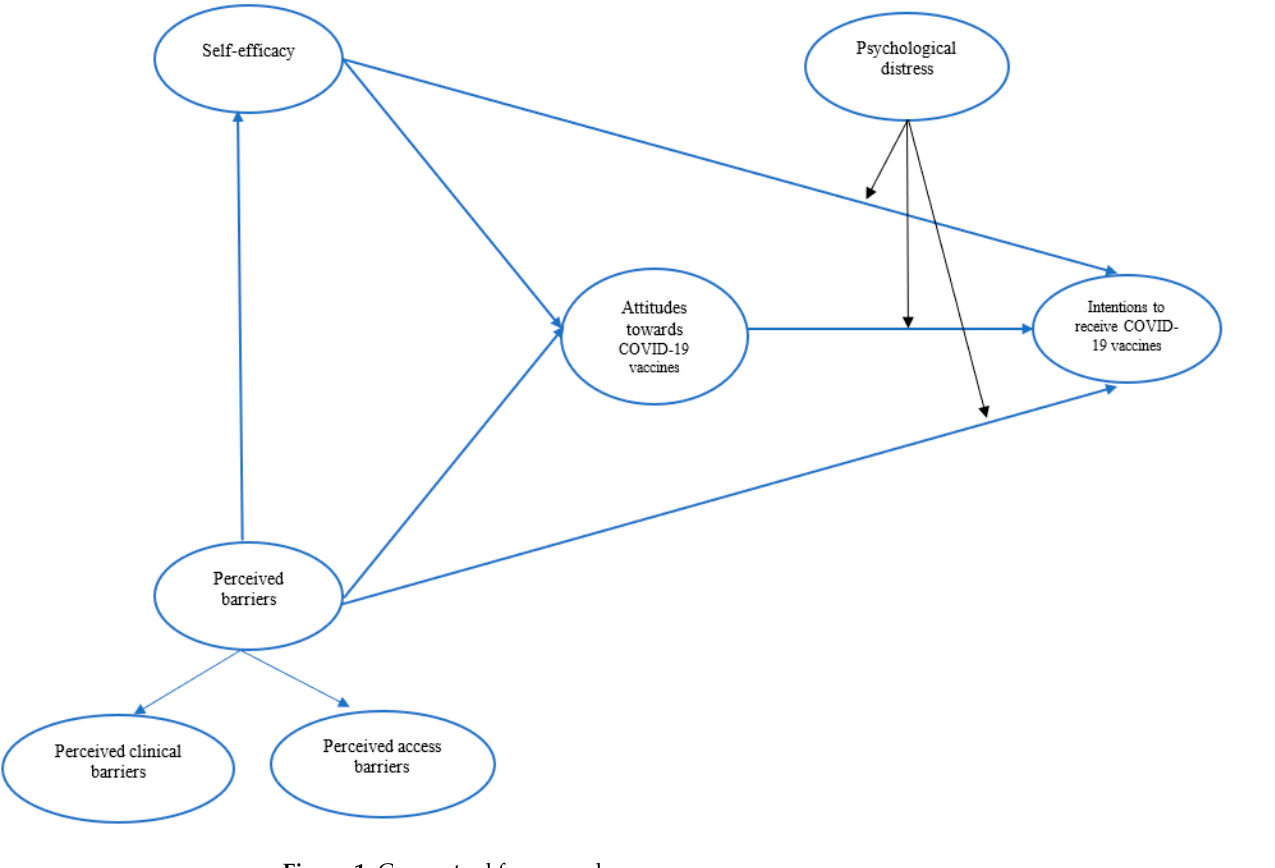
Figure 1. Conceptual framework.